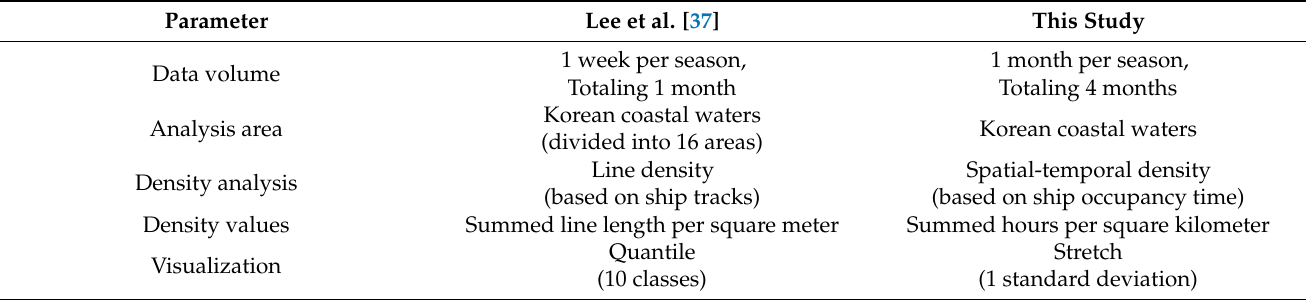
Table 5. Overall comparison of this study and Lee et al. [37] in terms of data, analysis methods, and